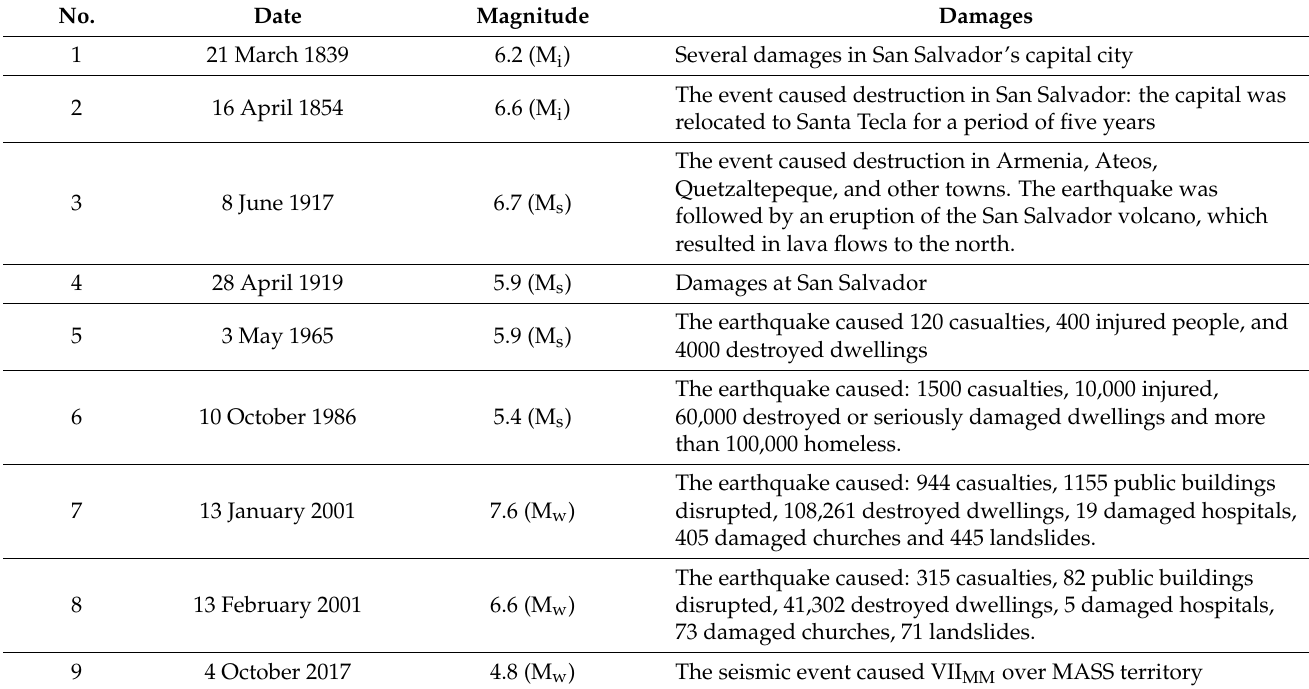
Table 2. The list of the principal strongest earthquakes that have caused damage and casualties in the municipality area of San Salvador [36,46,48,49]. (M i ) is the estimated surface wave magnitude deduced from isoseismal intensity